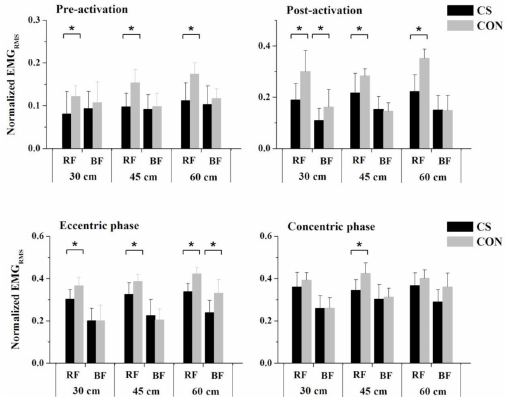
Figure 8. Compression effects on the EMG amplitude of rectus femoris (RF) and biceps femoris (BF) during landings. Upper-pointing brackets (*) indicate a significant difference at the certain height ( p <